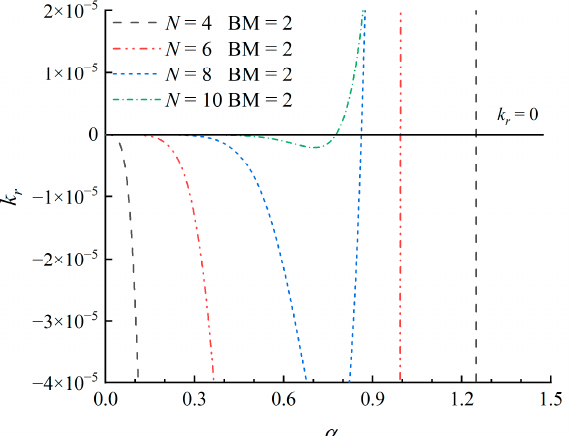
Figure 6. Locally enlarged version of the dissipation analysis of N ∈ even schemes.